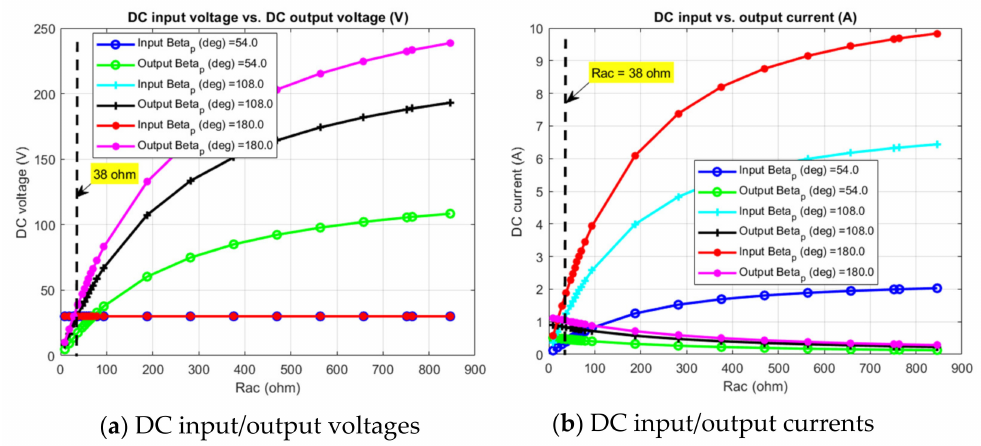
Figure 8. DC input/output voltages/currents vs. AC load resistance change.